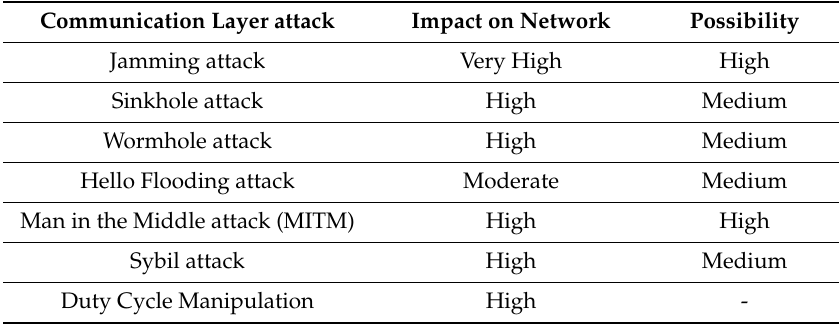
Table 2. Possible attacks and impacts on LPWAN communication layer